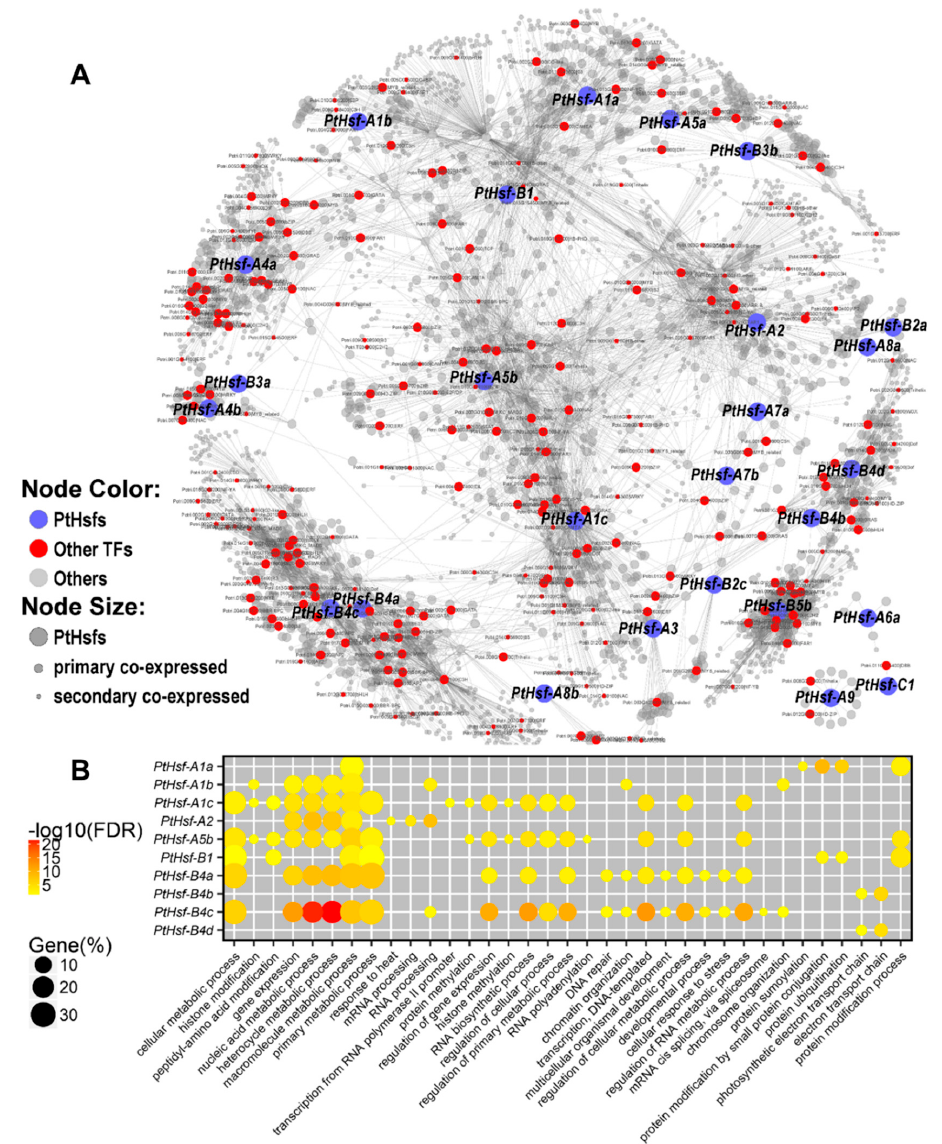
Figure 4. The co ‐ expression network of PtHsfs . ( A ) Co ‐ expression network of PtHsfs . Blue nodes indicate PtHsfs and red nodes indicate other transcription factors (TFs). ( B ) Gene ontology (GO) enrichment analysis co ‐ expression sub ‐ networks of ten PtHsfs genes. Yellow to red represents ‐ log10 transformed false discovery rate and node size indicates the percentage of GO enriched genes. GO enrichment was shown in Table S1.